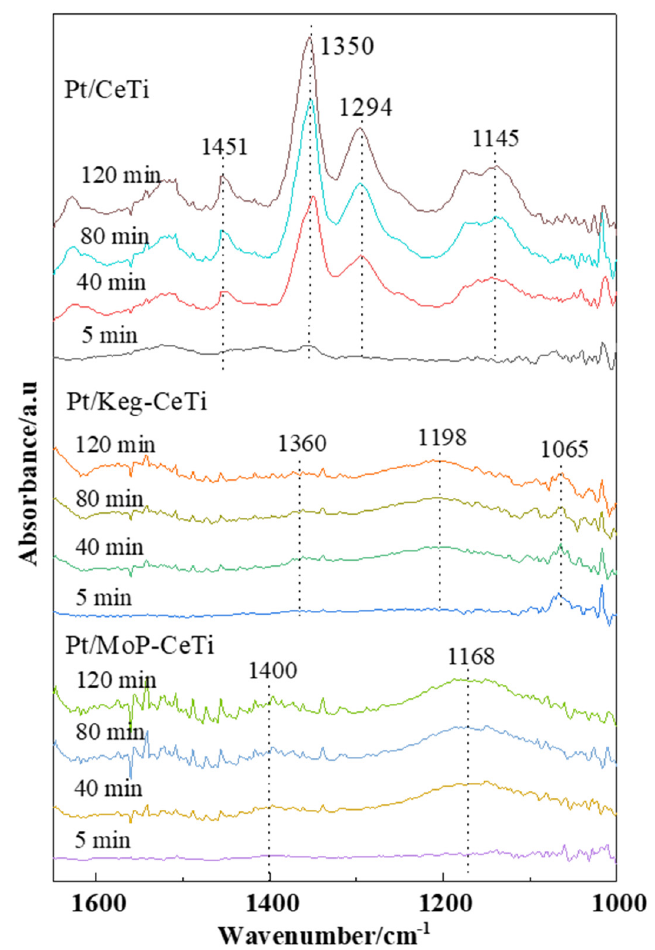
Figure 5. Changes in DRIFTS spectra of Pt/CeTi, Pt/Keg-CeTi, and Pt/MoP-CeTi with time. Condi- tions: [O 2 ] = 16 vol%, [SO 2 ] = 150 ppm, balance N 2 , total flow rate = 50 mL/min, at 250 °C.